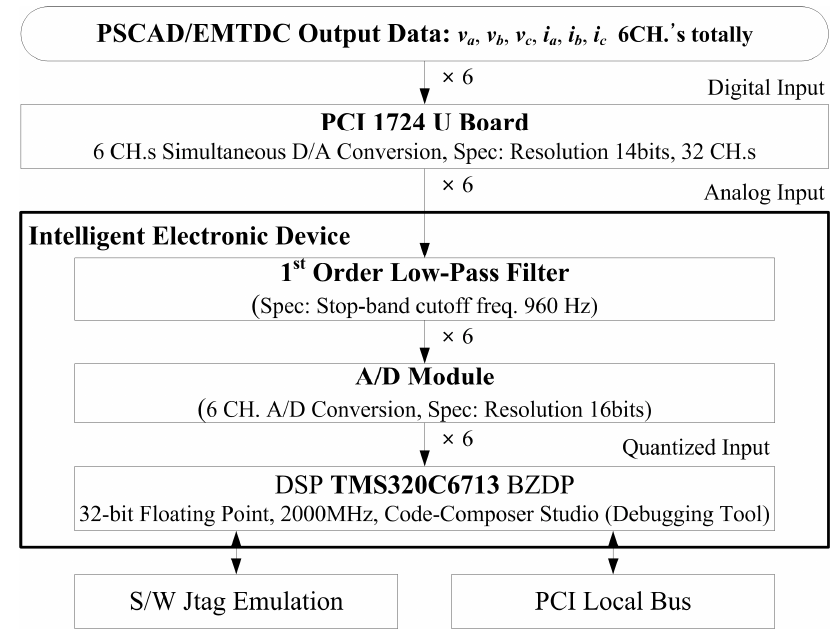
Figure 15. Configuration of hardware implementation.